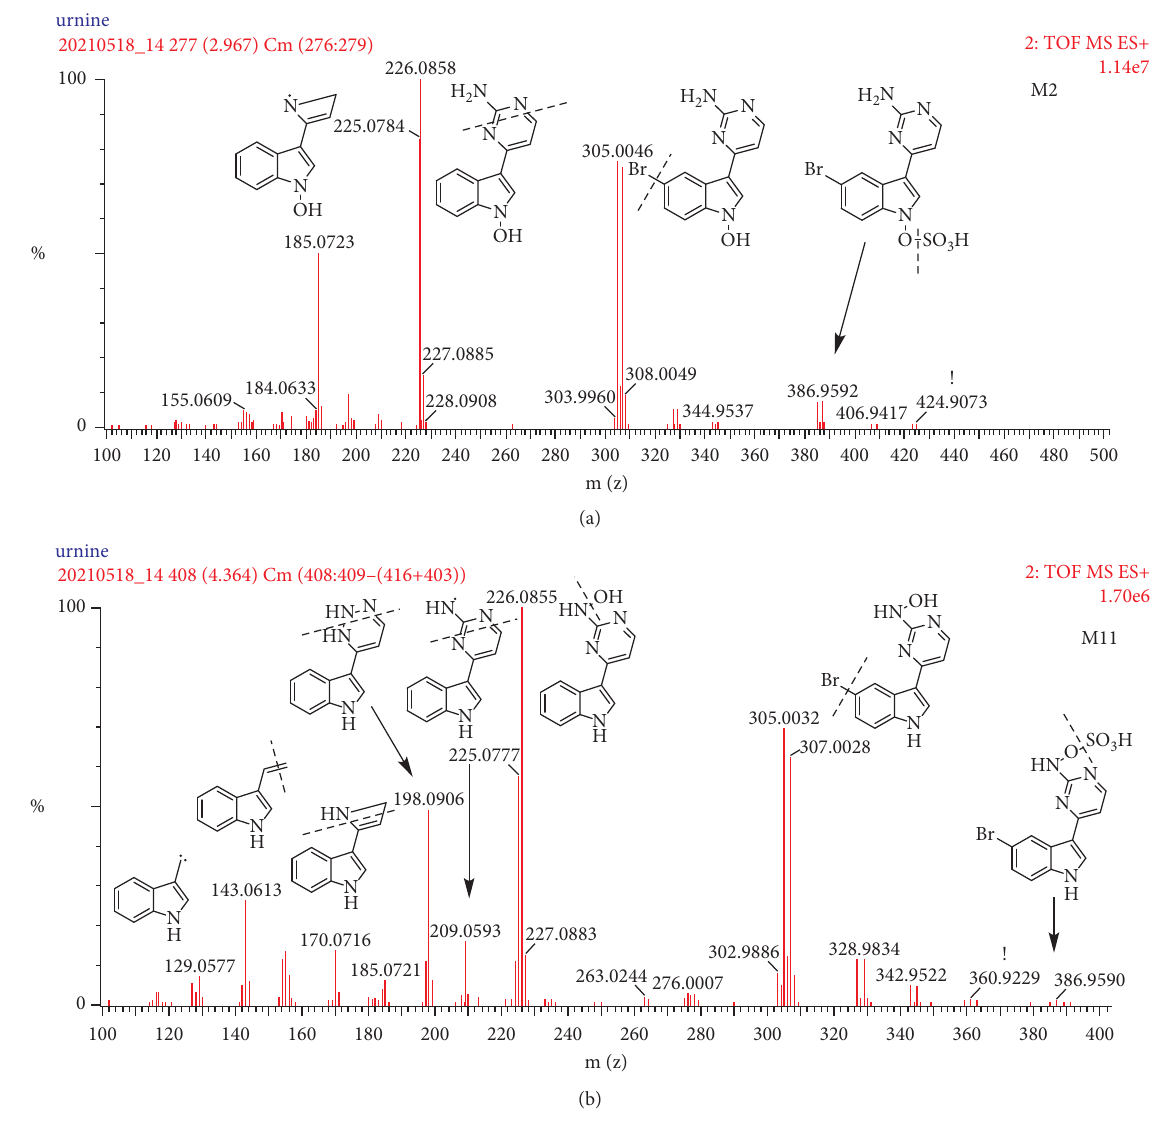
Figure 4: The product ion spectra and proposed fragmentation pathways of M2 and M11 in the positive ion